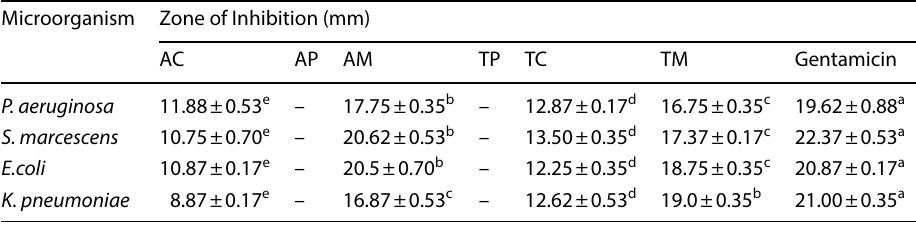
AC and TC, Chloroform extract; AP and TP, Petroleum ether; AM and TM, Methanol extracts of A. bella- donna and T. linearis respectively Note not available. Diameter of zone of inhibition is a mean of triplicate ± SD. Values are the means ± standard deviation. Different letters in superscript in each row are significantly different at (P < 0.05) by